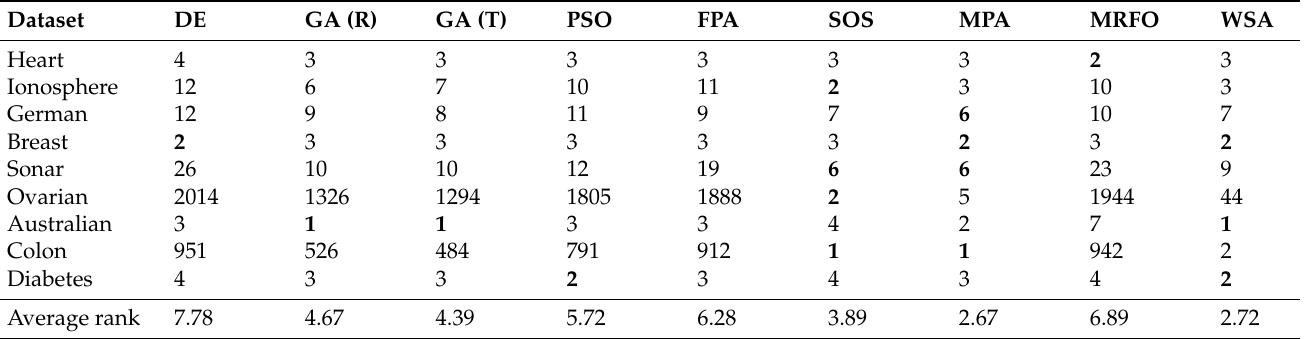
Table 9. Least features selected by each algorithm for each